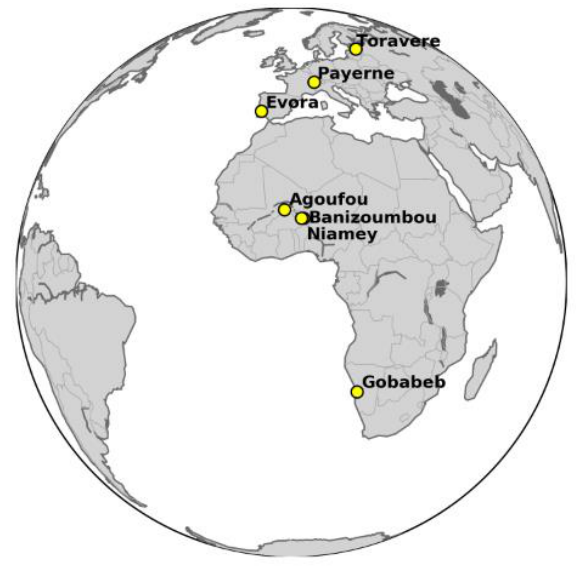
Figure 2. Location of the ground measurement